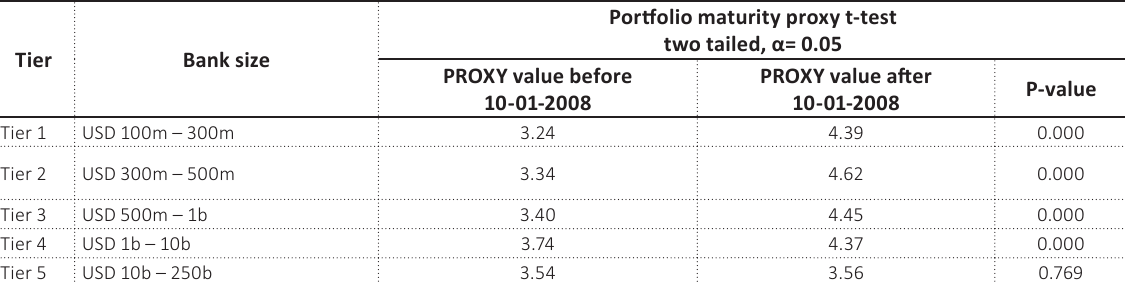
Table 4. T-Test results of average portfolio maturity proxy Tier